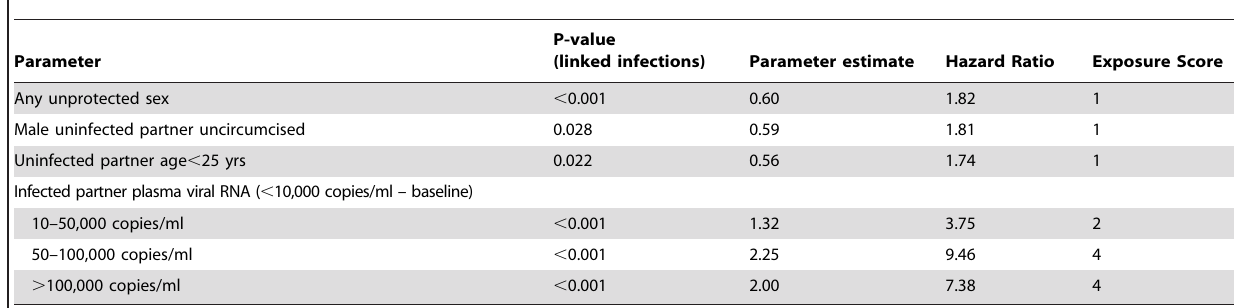
Table 1. Identification of HIV-1 exposure factors through a predictive model of HIV-1 transmission.